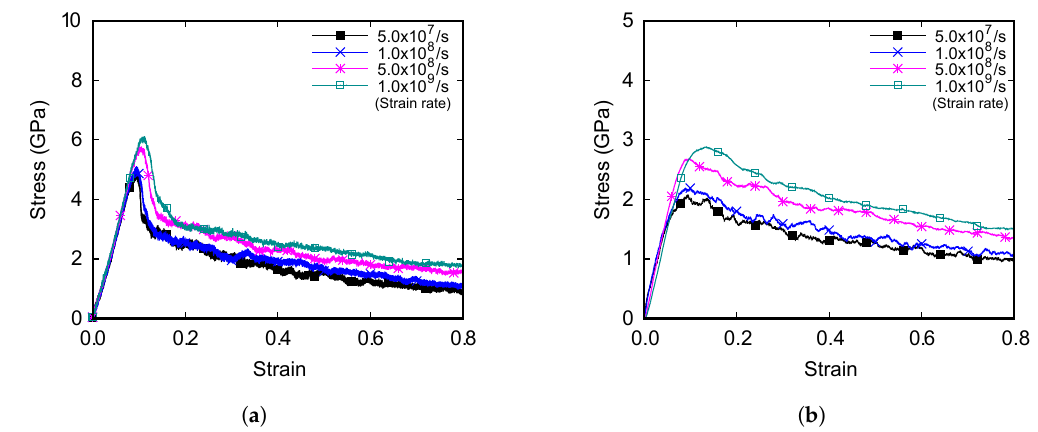
Figure 3. Stress-strain curves of the Cu-Zn alloys with the zinc content of ( a ) 2.5% and ( b ) 5%.